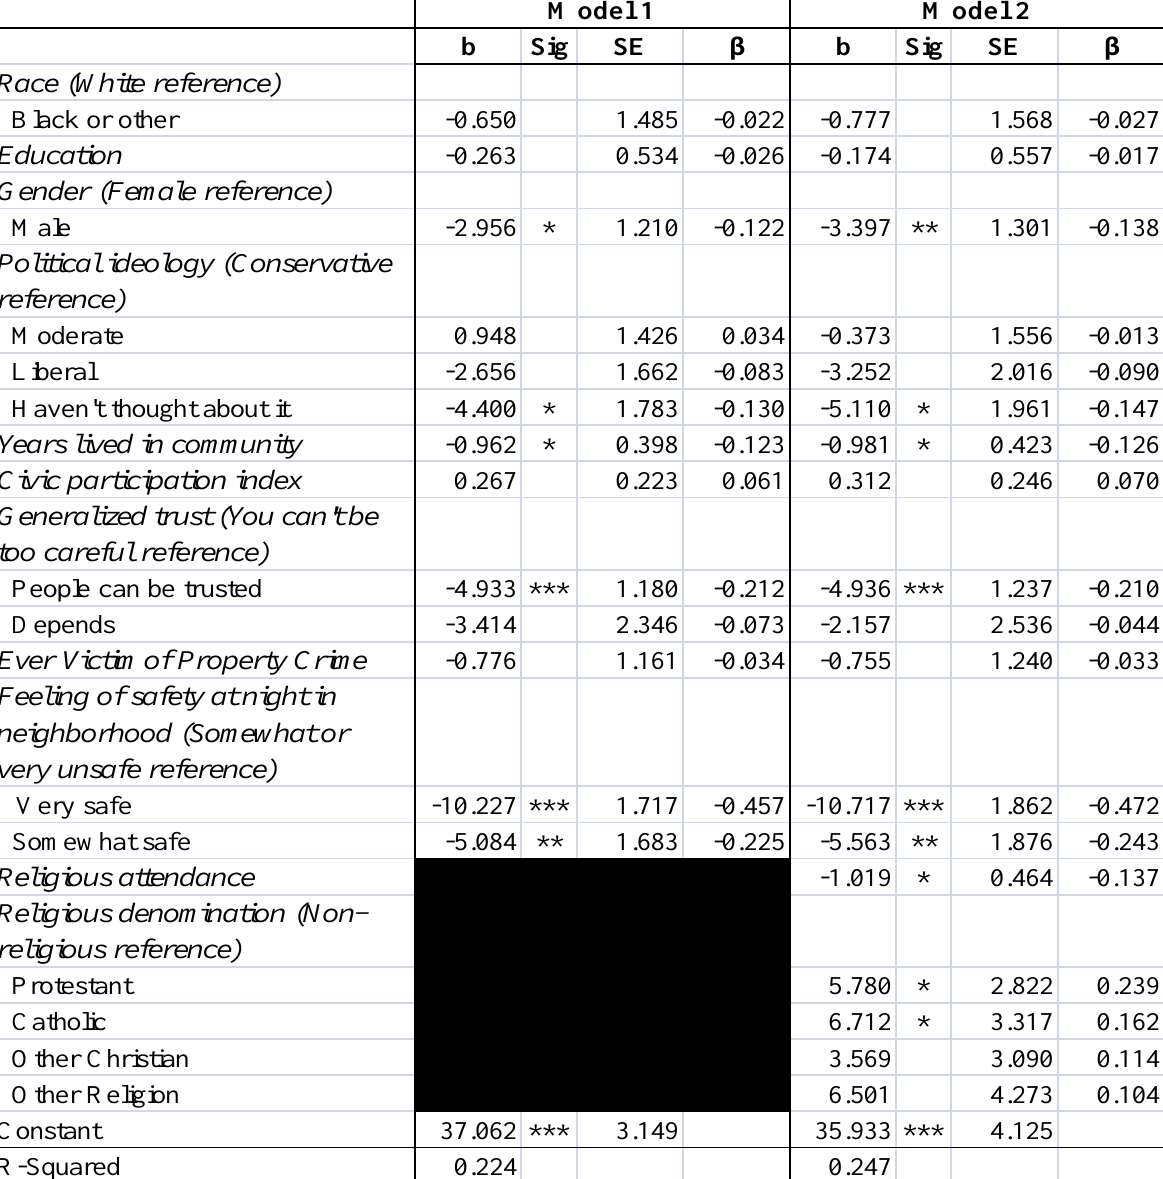
Table 2. Ordinary Least Squares (OLS) Regression of Predictors of Fear of Property Crime. b Sig SE β b Sig SE β